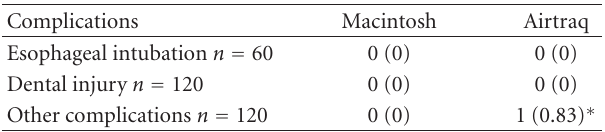
Table 5: Complications in the patients using the Airtraq and the Macintosh laryngoscopes. Data are shown as absolute numbers (percentage). ∗ Laryngoscope light